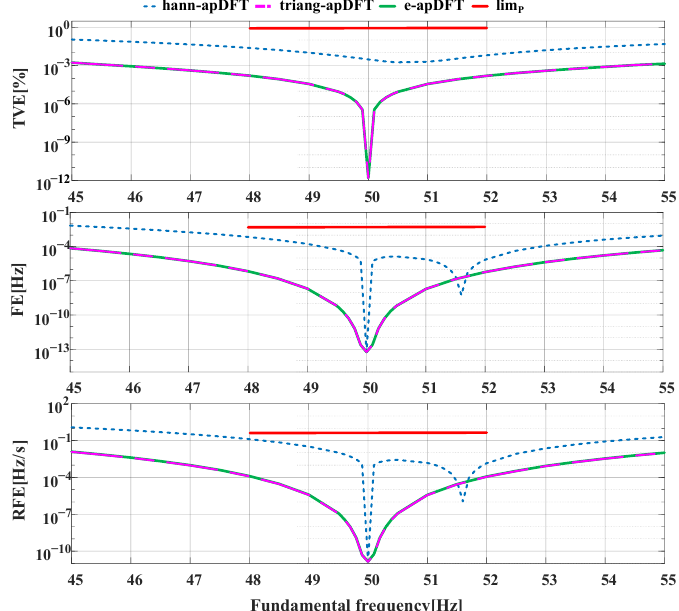
Figure 6. Signal frequency range test. Next, the harmonic distortion test is carried out. The frequency of the test signal is offset by 0.5 Hz, with a single harmonic. From the 2nd to the 50th harmonic, the amplitude is 1% of the fundamental amplitude. The maximum phasor error results are shown in Figure 7. As shown, the estimation error of the hann-apDFT algorithm is relatively stable, whereas the apDFT algorithms based on a triangular window are greatly affected by even harmonics. Even so, overall, the latter have a higher estimation accuracy. The key observation is that when the second harmonic exists, the phasor estimation accuracy of the hann-apDFT algorithm and the triang-apDFT algorithm is greatly reduced, while the e-apDFT maintains a high accuracy.